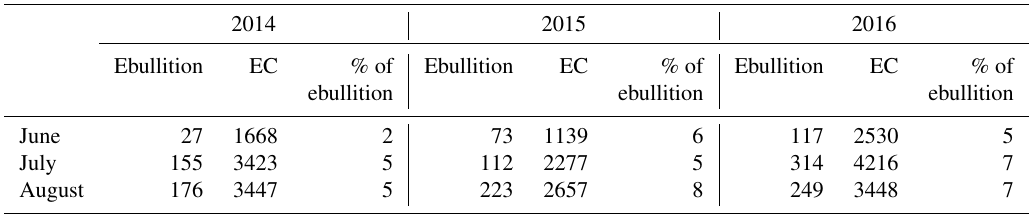
Table 3. Monthly cumulative methane fluxes (mgm − 2 month − 1 ), measured as ebullition and with the eddy covariance (EC) technique for June–August in the three studied years